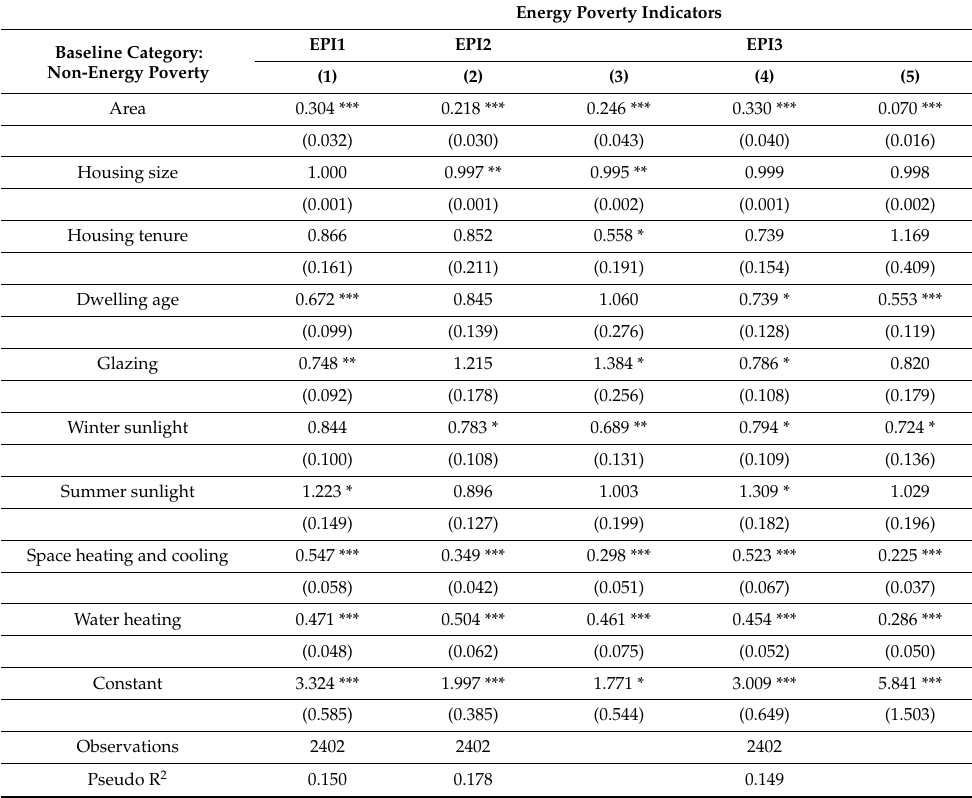
Table 2. Regression results of logit